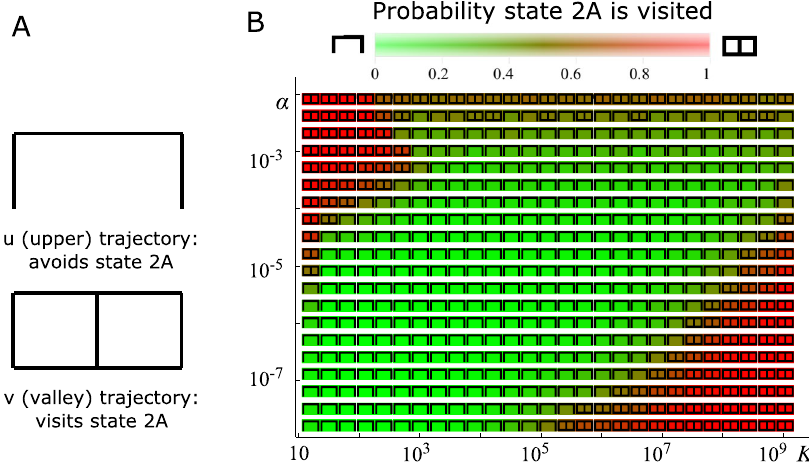
Figure 4. ( A ) Trajectories of successful cells can be grouped regarding whether they avoid (trajectory “u”) or visit (trajectory “v”) the fitness valley at state 2A. ( B ) The most common trajectory group and the probability of a trajectory visiting state 2A (colours, see the colour bar) as a function of switching rate α and carrying capacity K , for μ = 10 − 6 . In all simulations δ = 0.4 and d =